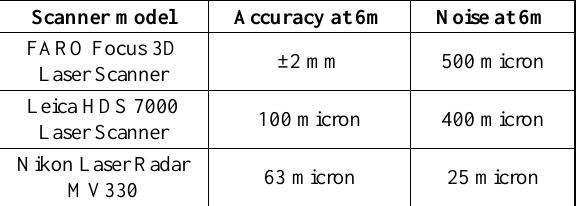
Table 3. Accuracy and noise of three commercial 3D laser scanners (data from manufacturers’ product